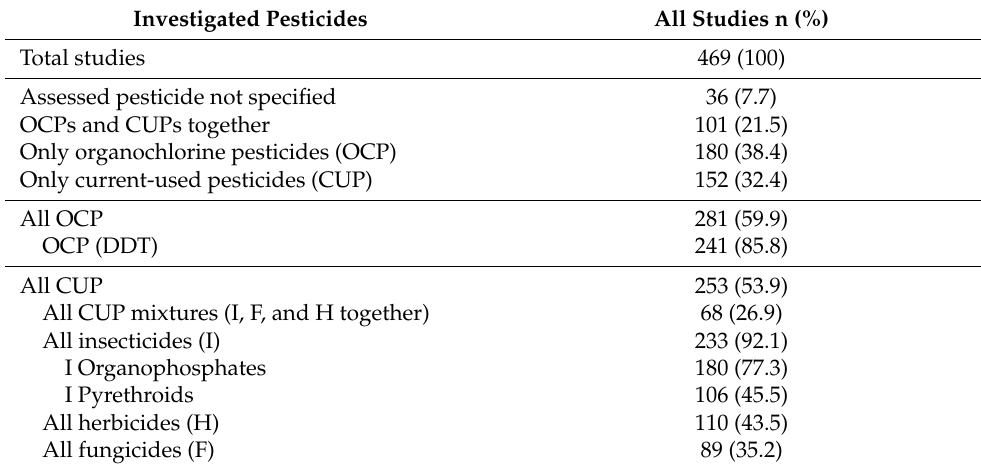
Table 1. Most investigated pesticide types and chemical groups across all 469 studies sites (number of study sites (%)).